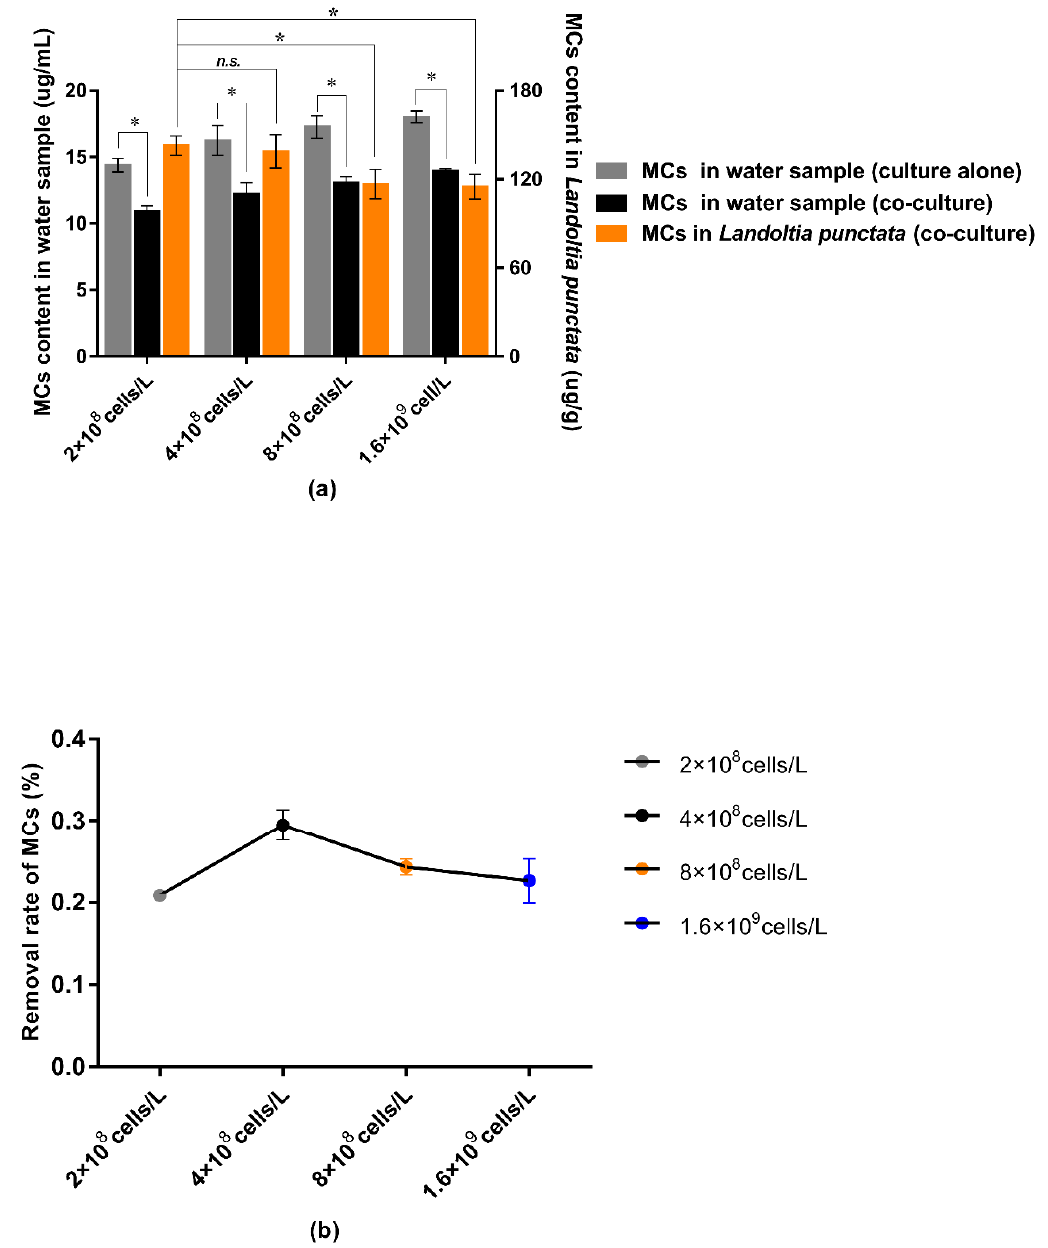
Figure 5. MC (microcystins) content and removal rate by L. punctata . ( a ) MC content in water sample and L. punctata . ( b ) Removal rate of MCs by L. punctata . Values are means ± SE from three biological replicates. Asterisks indicate statistical significance based on Student’s t test; * p < 0.05, n.s. indicates no significance.